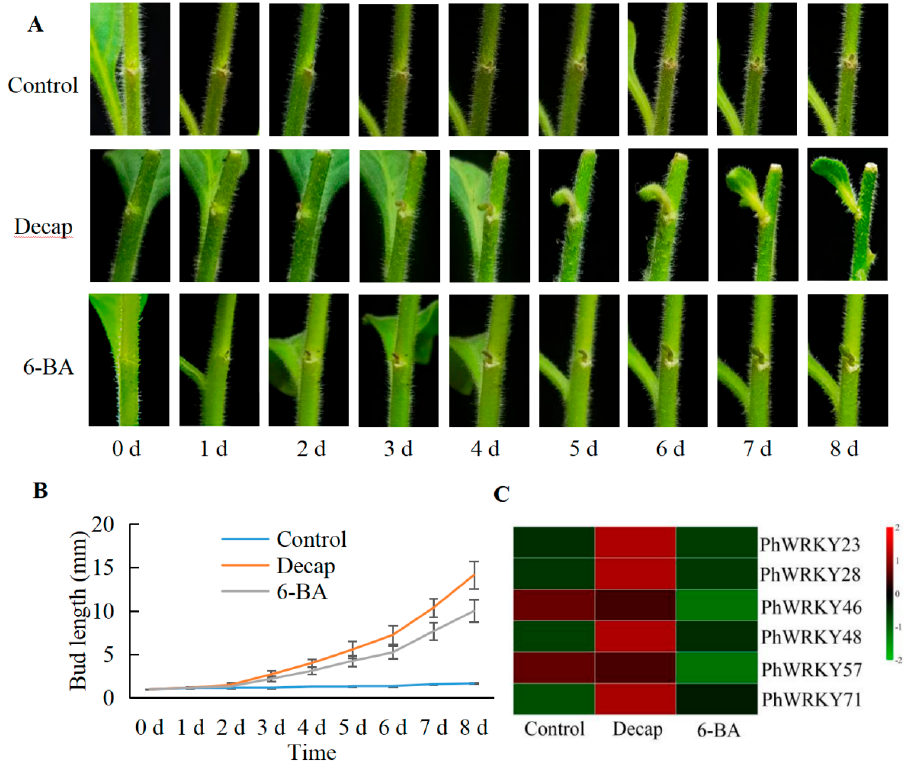
Figure 5. Response of Petunia × hybrida cv ‘Mitchell Diploid’ seedlings and PhWRKY genes to decapitation (decap) or 6-BA treatment. ( A , B ) Decapitation and application of 6-BA promoted the bud outgrowth of axillary buds. ( C ) Response of six PhWRKY genes to decapitation and 6-BA